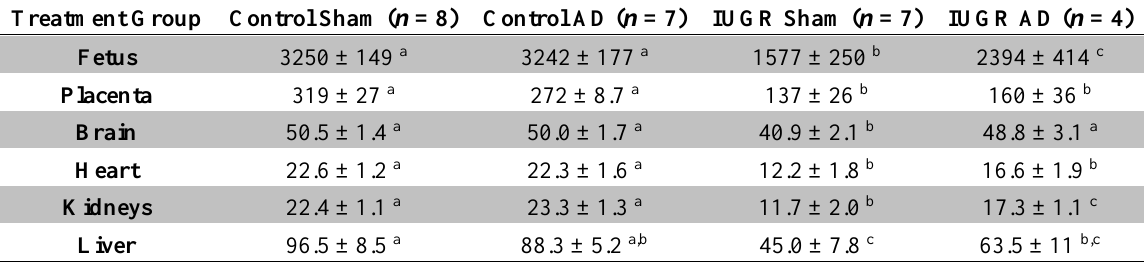
Treatments with different superscripts differ ( p <